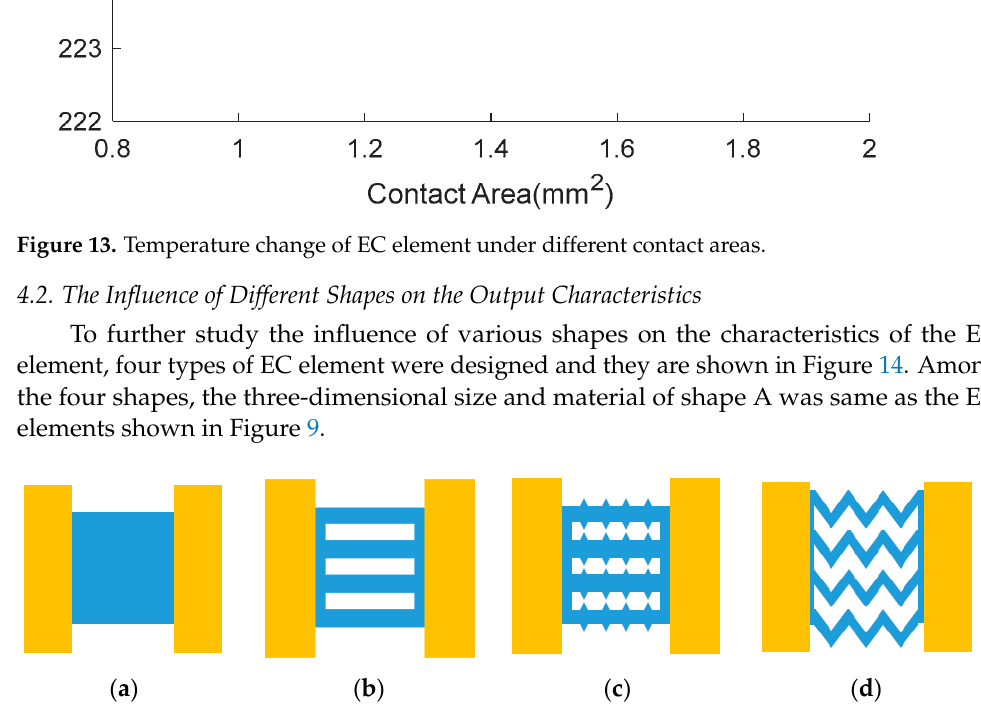
Figure 14. Four types of EC elements. ( a ) shape A; ( b ) shape B; ( c ) shape C; ( d ) shape D.